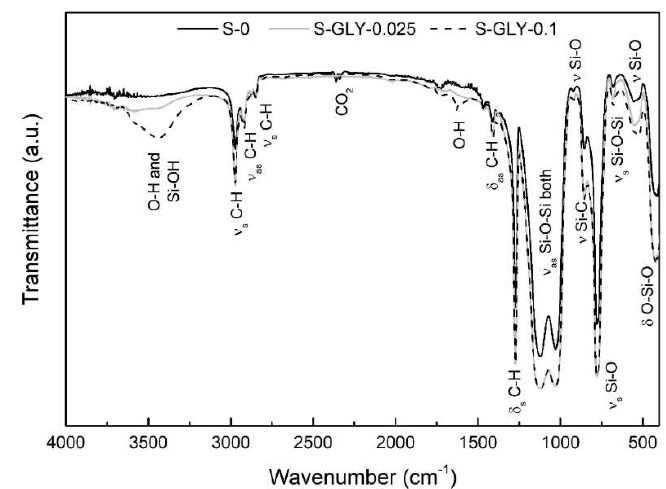
Figure 2. FTIR spectra for aerogel-like samples with and without GLY additive. ν—stretching vibration; ν s —symmetric stretching vibration; ν as —asymmetric stretching vibration; δ—deformation vibration; δ s —symmetric deformation vibration (bending); δ as —asymmetric deformation vibration (bending).